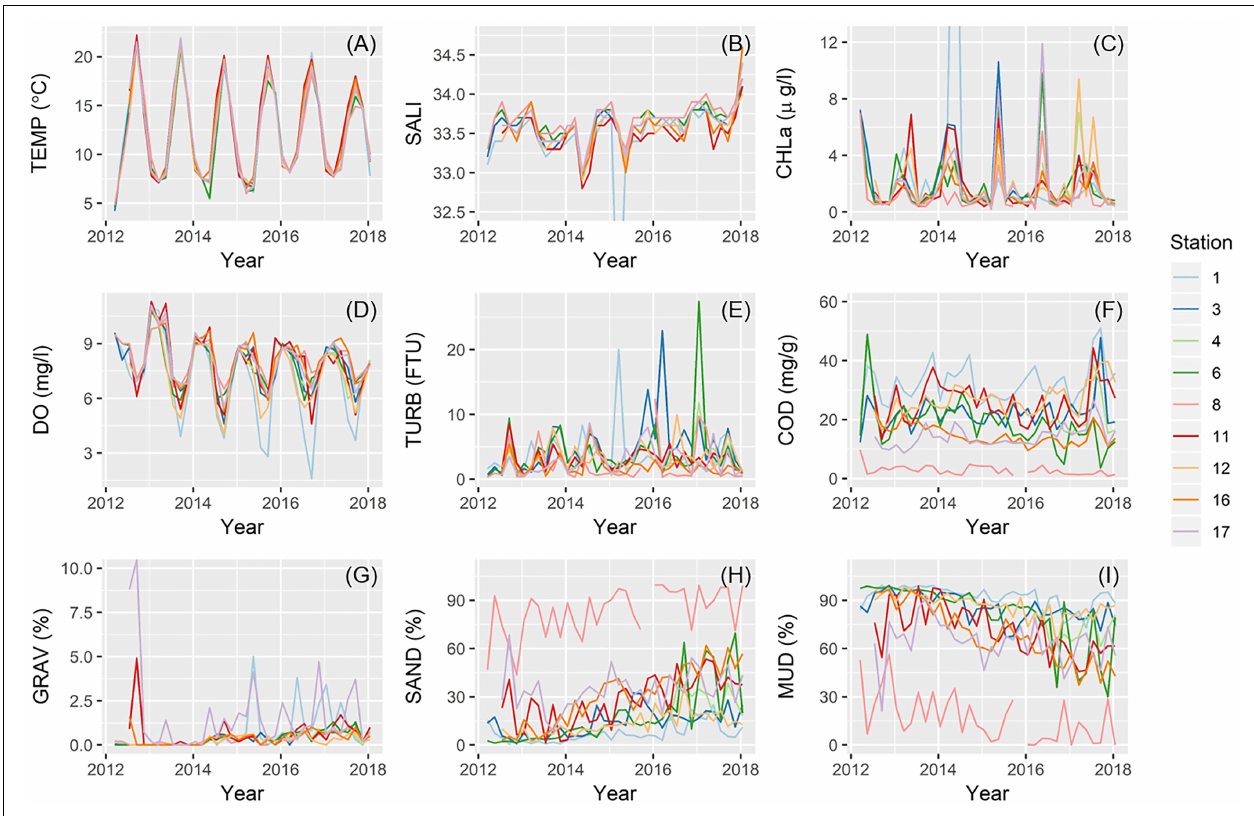
FIGURE 6 | Temporal change in environmental parameters across sampling stations for: (A) temperature; (B) salinity; (C) chlorophyll-a concentration; (D) DO; (E) turbidity; (F) COD; (G) gravel content; (H) sand content; and (I) mud